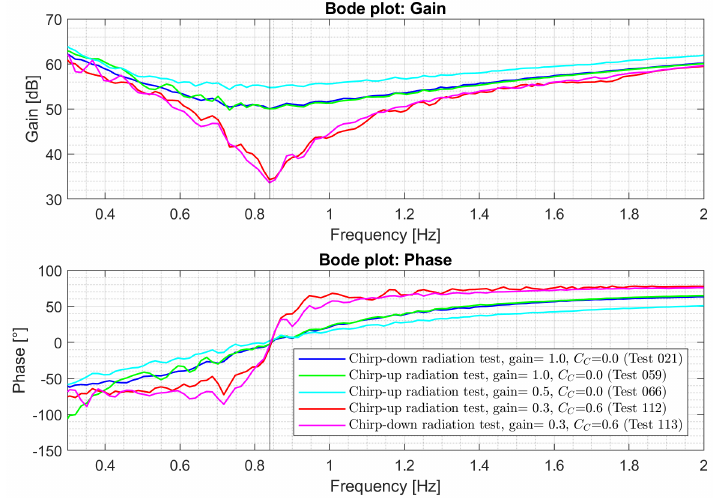
Figure 11. Bode plot of the experimentally identified Z i for Test_021 , Test_059, Test_066, Test_112 and Test_113.